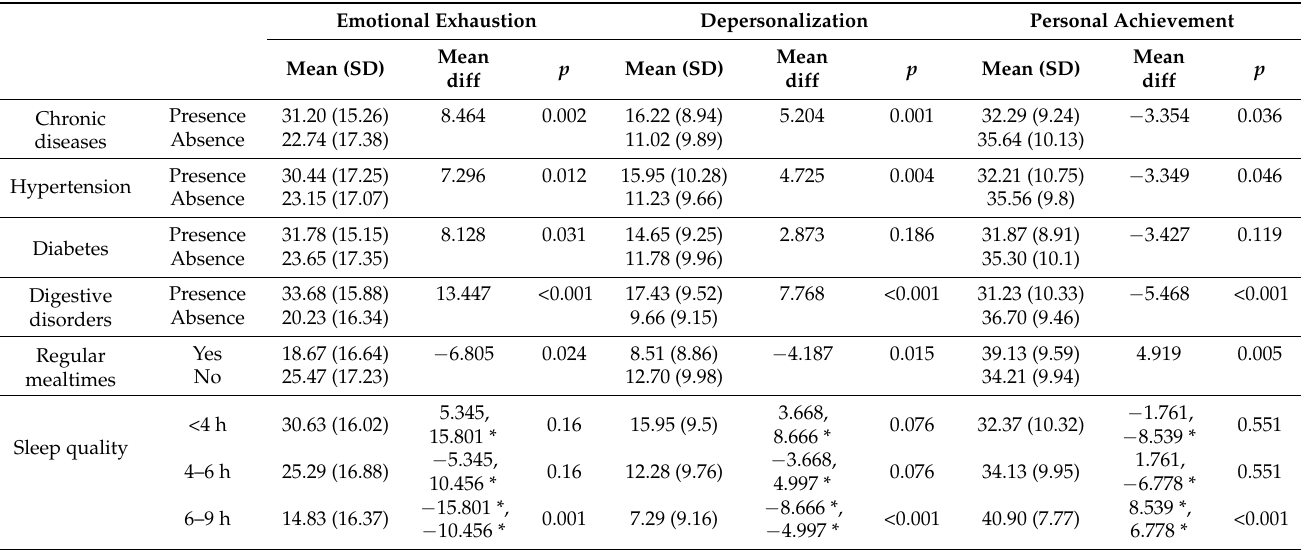
Table 5. Mean difference analysis of health variables with three dimensions of Burnout Syndrome in Mexican police